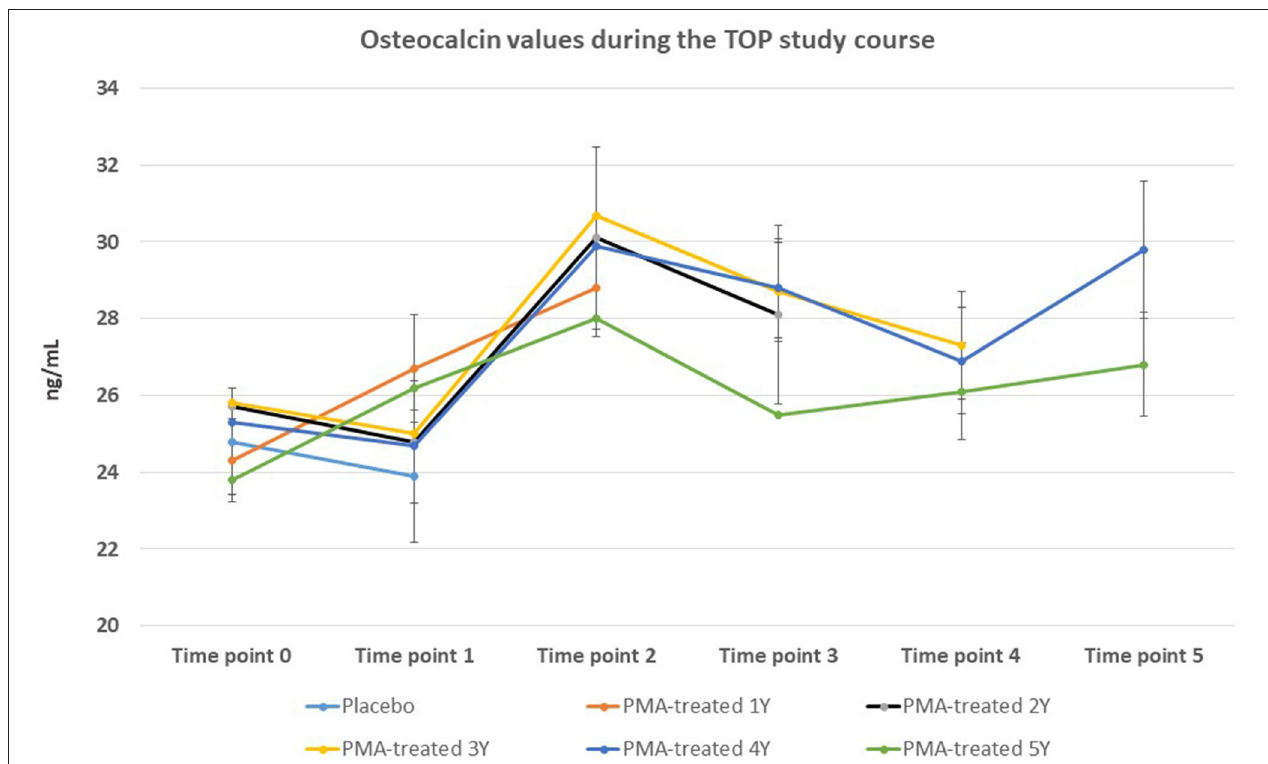
FIGURE 3 | Changes in osteoclacin values from the beginning of the study (time point 0) until the end of study (time point 5) for Placebo and PMA-treated patients. A separate representation for the patients enrolled as Placebo group at time point 0 (later treated with PMA-zeolite from time point 1–5) and enrolled patients treated with PMA-zeolite from the beginning of the study (time point 0–5) is given in the Supplementary Figure 1 . TABLE 2 | Analysis of values relevant for the quality of life in Placebo at the end of the TOP study first year vs. PMA-treated patients—final at the end of the TOP study. p Placebo at the end of first year PMA-treated patients—final at the ( N = 40) end of the study ( N = 55) Bone fractures before entering the study , n (%) 9 (22.5%) 9 (29.0%)